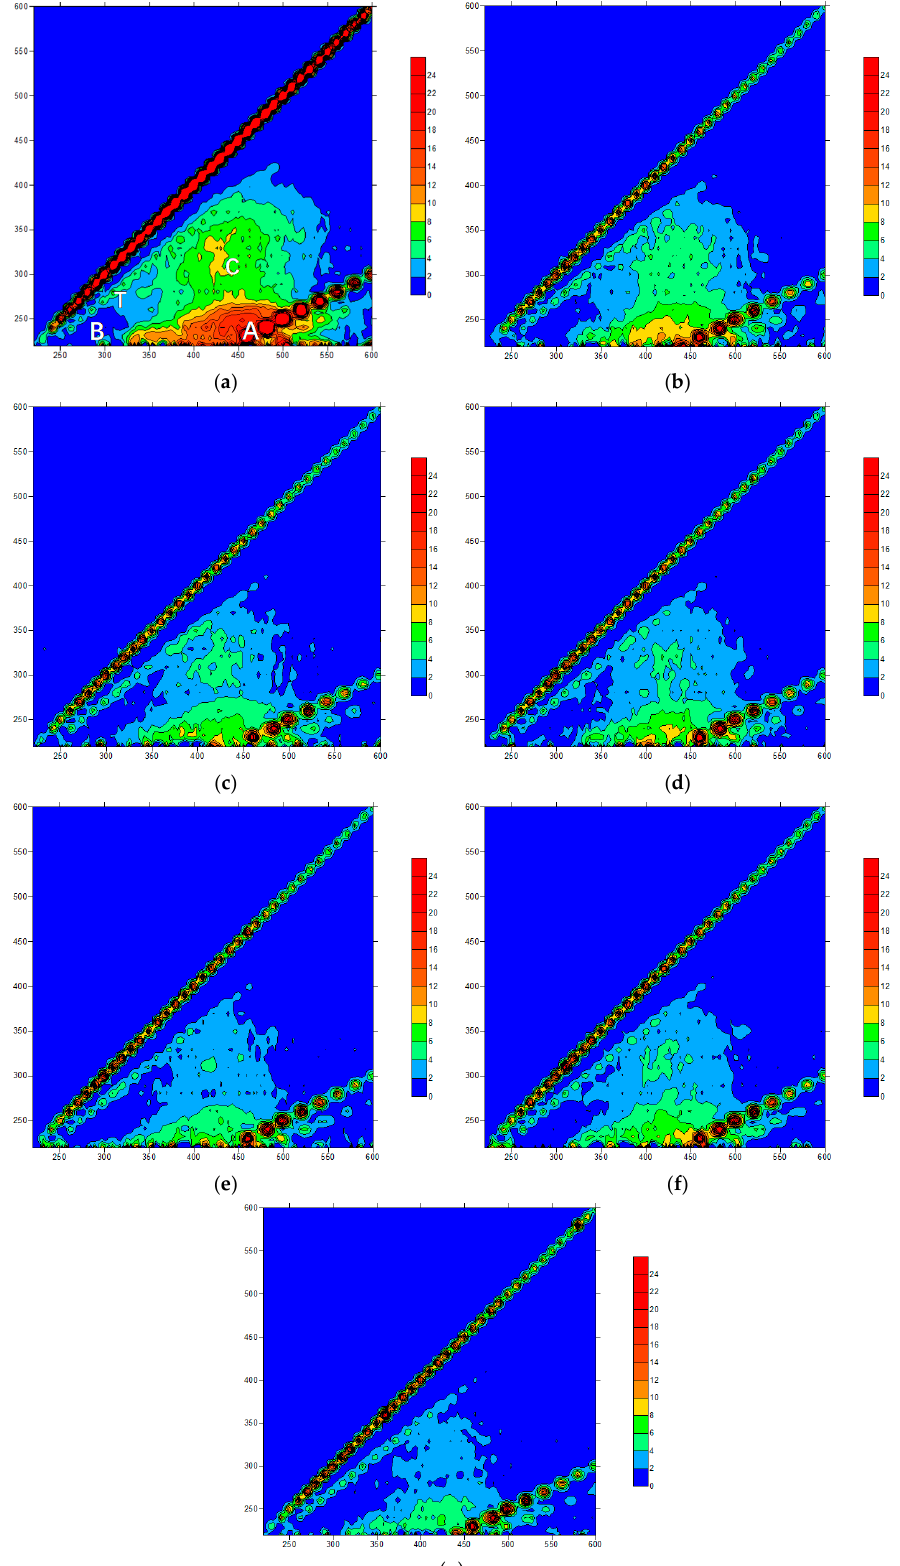
Figure 5. Fluorescence spectra of raw water and NaClO pre-oxidized effluent: ( a ) raw water; ( b ) 1.0 mg/L; ( c ) 1.0 mg/L + PAC; ( d ) 1.5 mg/L; ( e ) 1.5 mg/L + PAC; ( f ) 2.0 mg/L; ( g ) 2.0 mg/L +